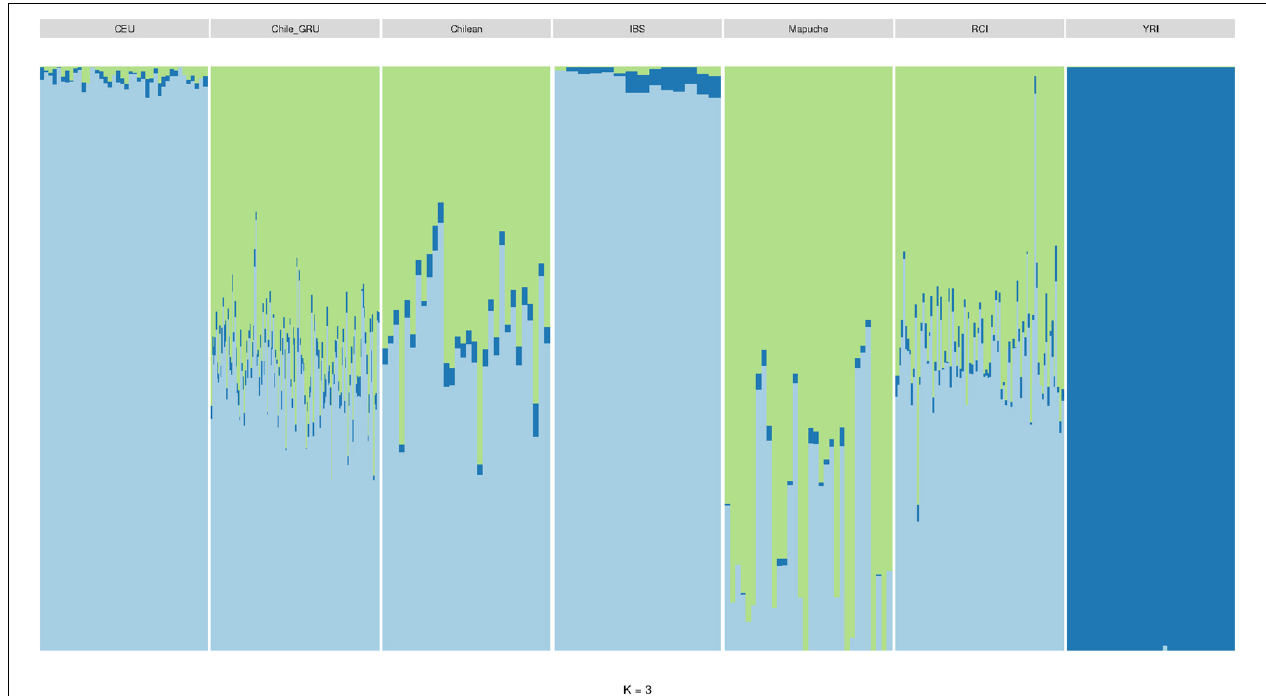
FIGURE 6 | ADMIXTURE bar plot ( K = 3) showing the estimations of ancestry in Europeans (CEU) ( N = 40), Chile_GRU (non-indigenous) ( N = 144), Chilean controls (from Santiago) ( N = 30), Iberian (IBS) ( N = 14), Mapuche ( N = 32), Robinson Crusoe Island (RCI) ( N = 86), and African Yoruba (YRI) ( N = 40)